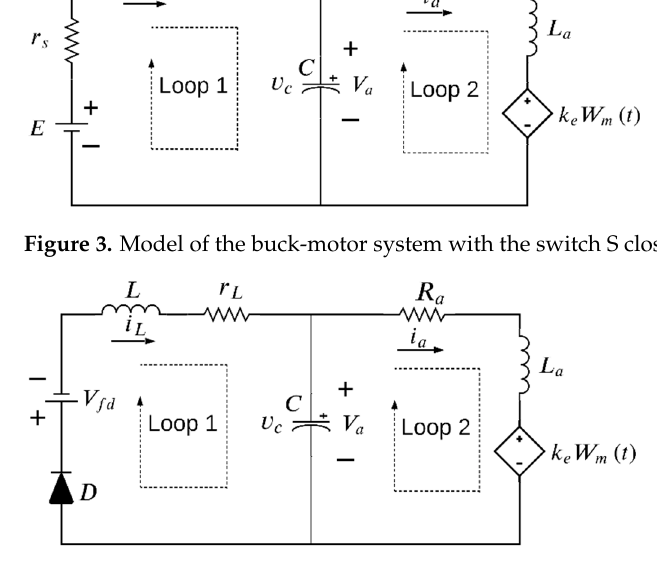
Figure 4. Model of the buck-motor system with the switch S open.